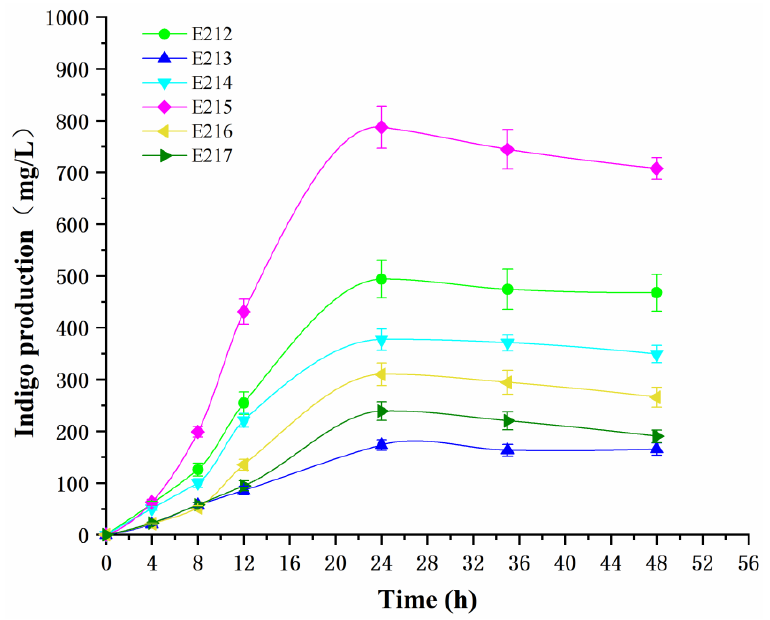
Figure 5. Indigo production of strains E212, E213, E214, E215, E216 and E217 under fermentation conditions with 2.0 g/L of tryptophan as substrate at different times.